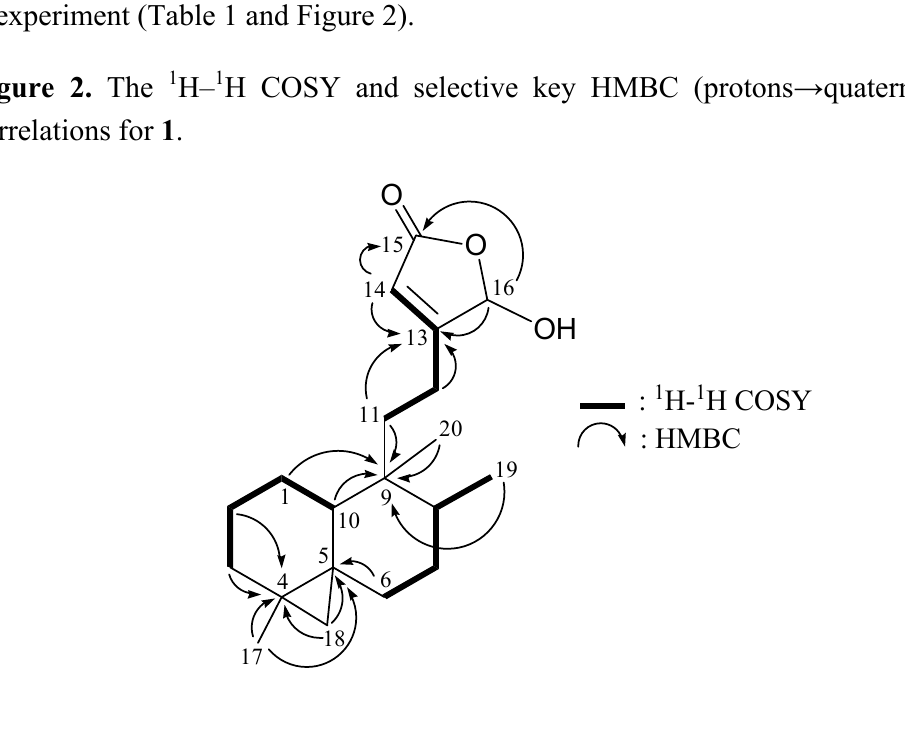
Table 1. 1 H- (400 MHz, CDCl HMBC correlations for diterpenoid 1 .